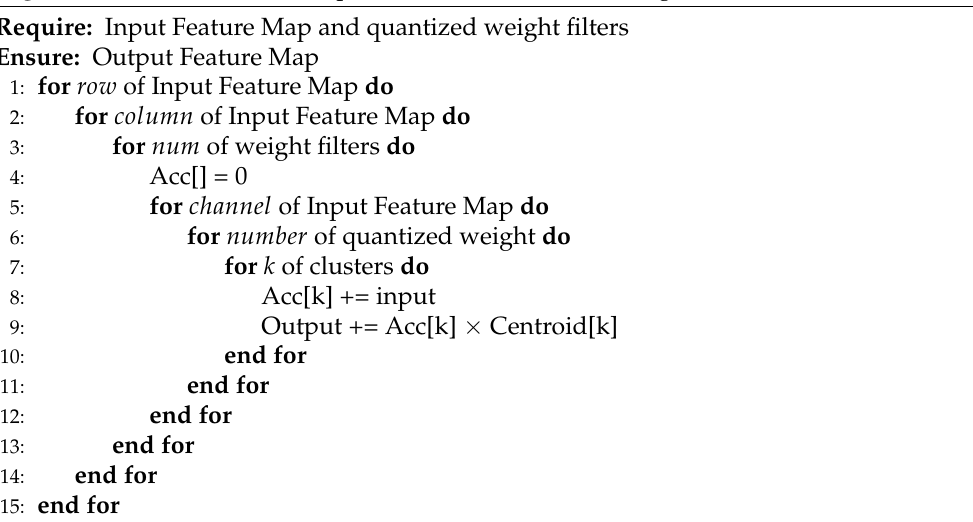
Algorithm 2 Convolution Computation with Quantized Weight